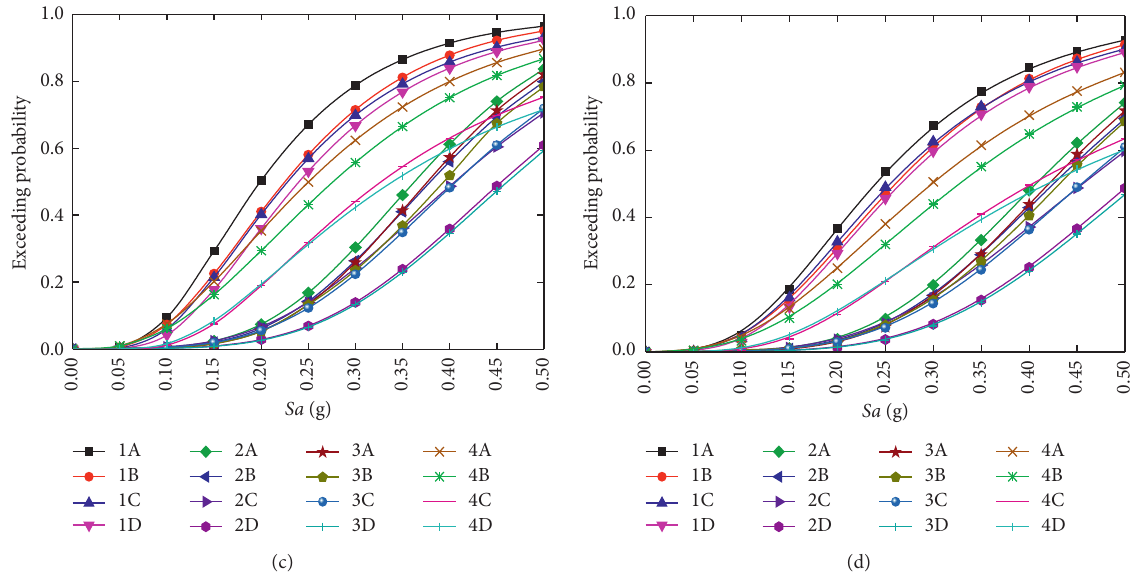
Figure 8: Fragility curves of key sections under the longitudinal seismic action. (a) Slightly damaged. (b) Moderately damaged. (c) Severely damaged. (d) Completely damaged.